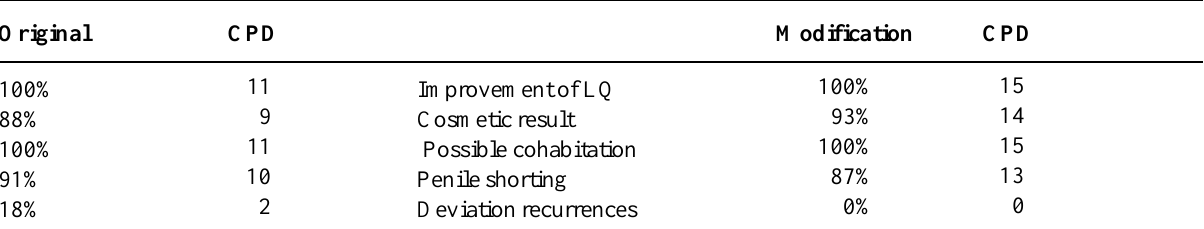
Table 1 - Comparison of Schroeder-Essed procedure and the modified technique. Original